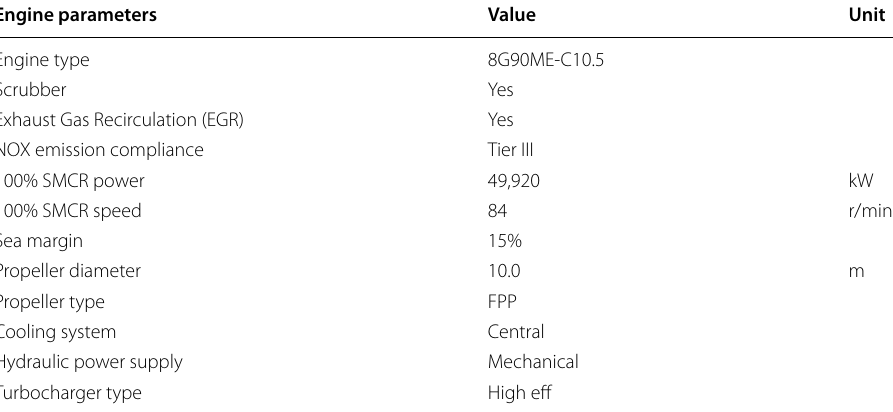
Table 11 Engine specifications for the engine assumed to calculate fuel efficiency for all diesel-like fuels. Source MAN (2020)